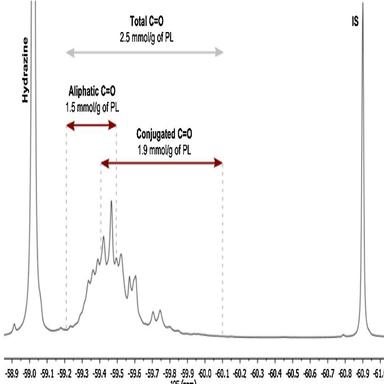
19F NMR spectrum of PL and integration results of assigned regions (solvent: DMSO-d6).